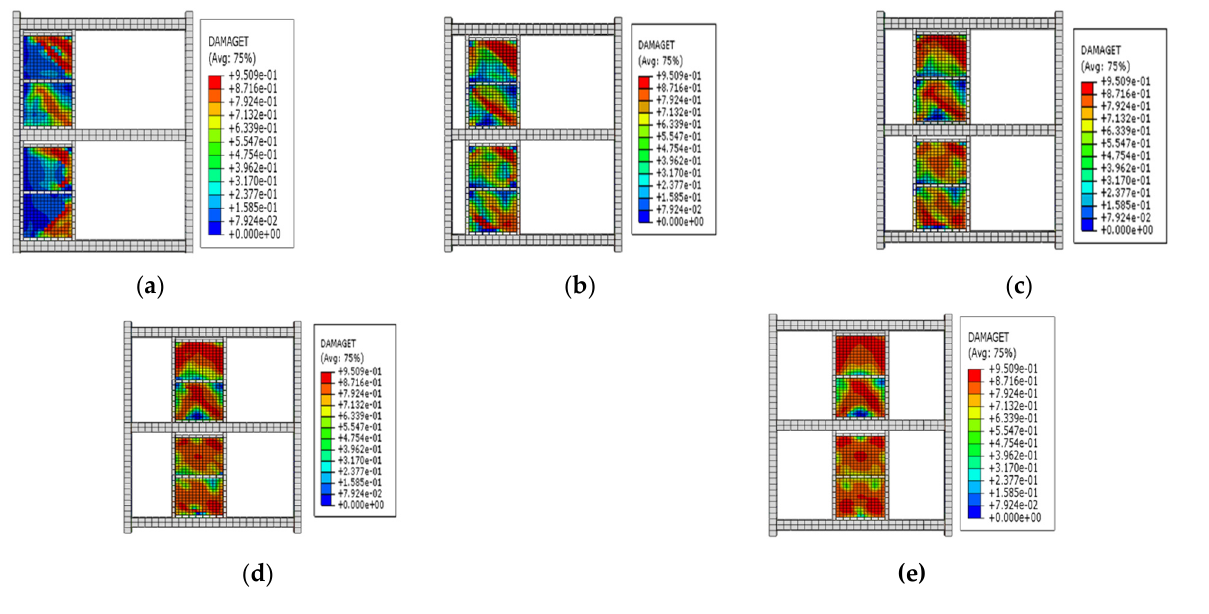
Figure 16. Stress contour plots of the EDCWs installed at different locations. ( a ) F6; ( b ) F7; ( c ) F8; ( d ) F9; and ( e ) F10.